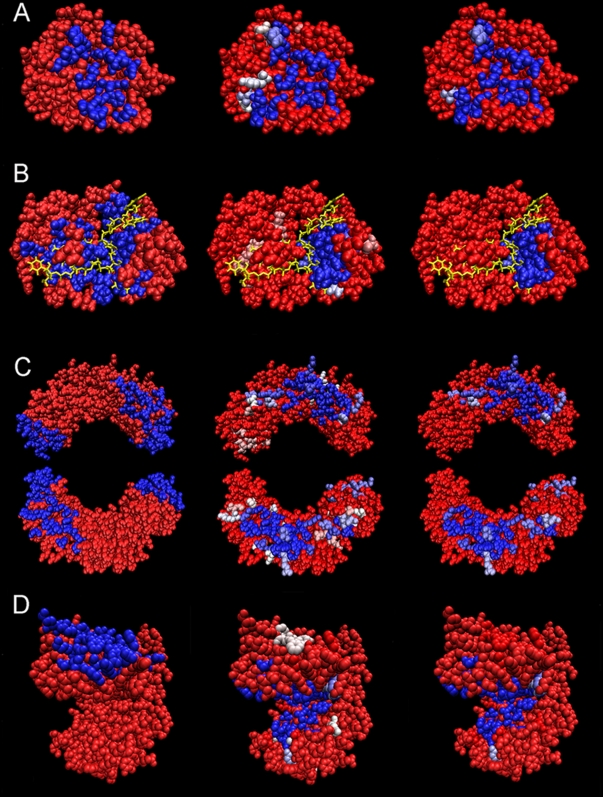
iJET predictions and consensus on residues.Structures: β-trypsin proteinase 2ptc (A),
RNA-binding protein 2cjk (with the RNA chain in yellow) (B),
nucleotidyltransferase 2pol (C), oxidoreductase 1leh (D). Left:
experimental interaction site (blue). Center: residues appeared at least
2, 2, 3, and 4 times respectively for structures (A–D) over 10
iterations of JET. Right: residues appeared 7/10 times (that is, at
least 7 times out of 10 iterations of JET). Central and right columns:
predicted residues are colored from blue to pink depending on number of
iterations selecting the residue out of 10 runs; dark blue for 10/10,
white for 7/10 and dark pink for 2/10.